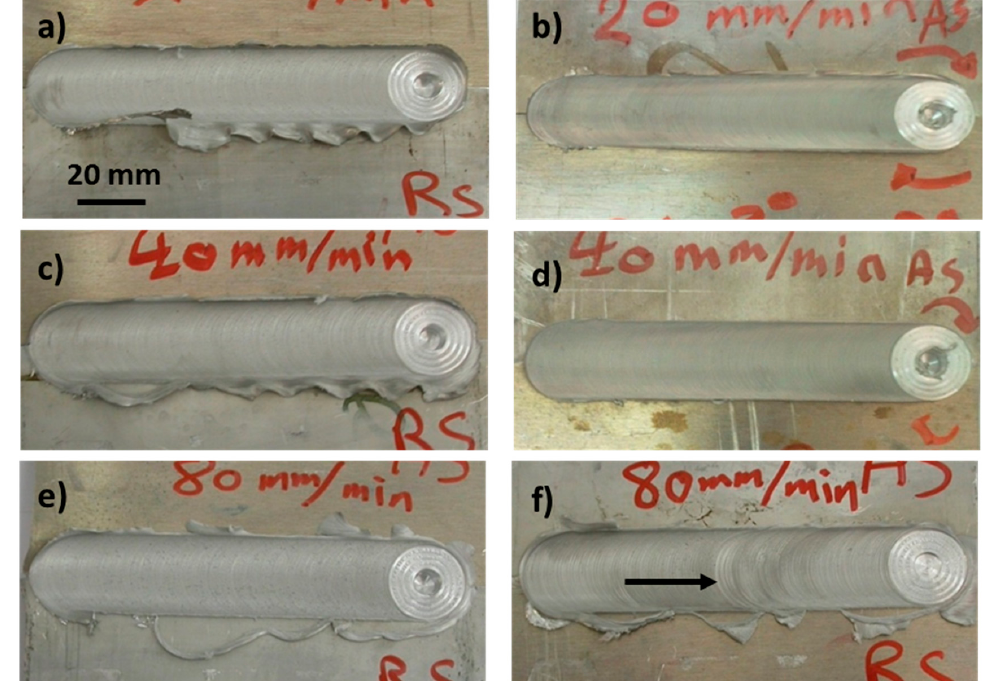
Figure 6. Surface appearance of friction stir welded joints AA5083/AA7020 at different rotation and traverse speeds: ( a ) AA5083/AA7020, 500 rpm, 20 mm/min, ( b ) AA7020/AA5083, 500 rpm, 20 mm/min, ( c ) AA5083/AA7020, 500 rpm, 40 mm/min, ( d ) AA7020/AA5083, 500 rpm, 40 mm/min, ( e ) AA5083/AA7020, 500 rpm, 80 mm/min and ( f ) AA7020/AA5083, 500 rpm, 80 mm/min.